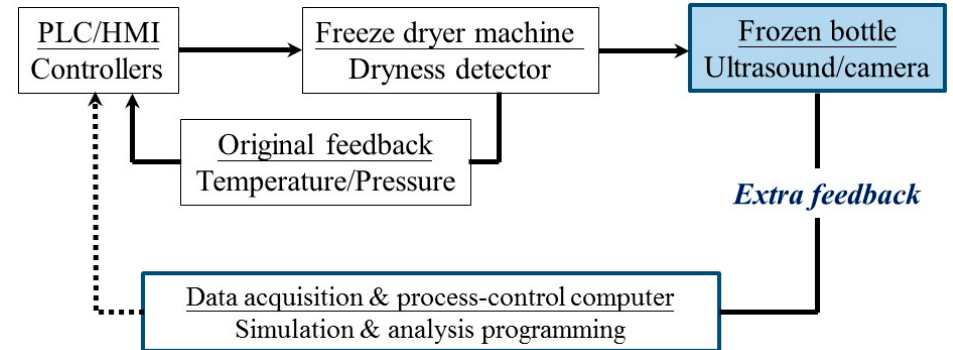
Figure 1. Controlling structure of the freeze-drying process by using the innovative frozen bottle